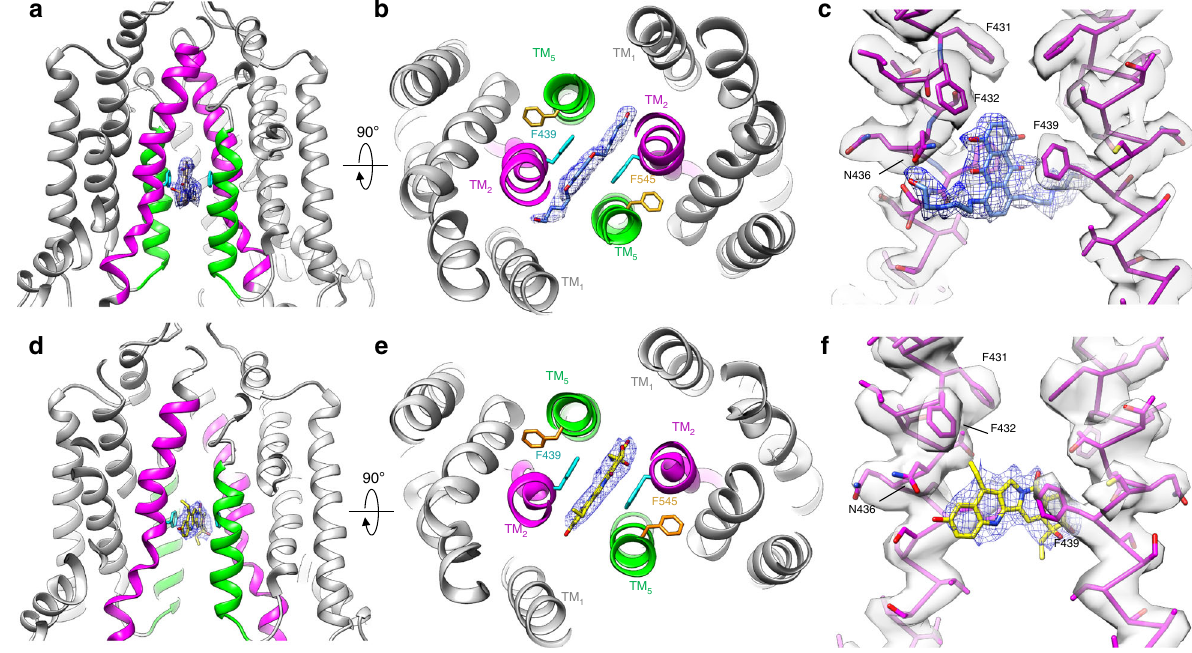
Fig. 4 Binding of MXN and SN38 to ABCG2. a View of ABCG2 TM helices in the inward conformation bound to MXN. TM2 is colored magenta, and TM5 is colored green. b View from the extracellular space showing that MXN binds between Phe439 from opposing monomers. c Zoomed-in view of the MXN binding site with MXN shown in blue. TM2 and associated density from each monomer is shown as magenta sticks. d View of ABCG2 TM helices in the inward conformation bound to SN38. TM2 is colored magenta, and TM5 is colored green. e View from the extracellular space showing that SN38 binds between Phe439 from opposing monomers. f Zoomed-in view of the SN38 binding site with SN38 shown as yellow sticks. TM2 is shown as magenta sticks.